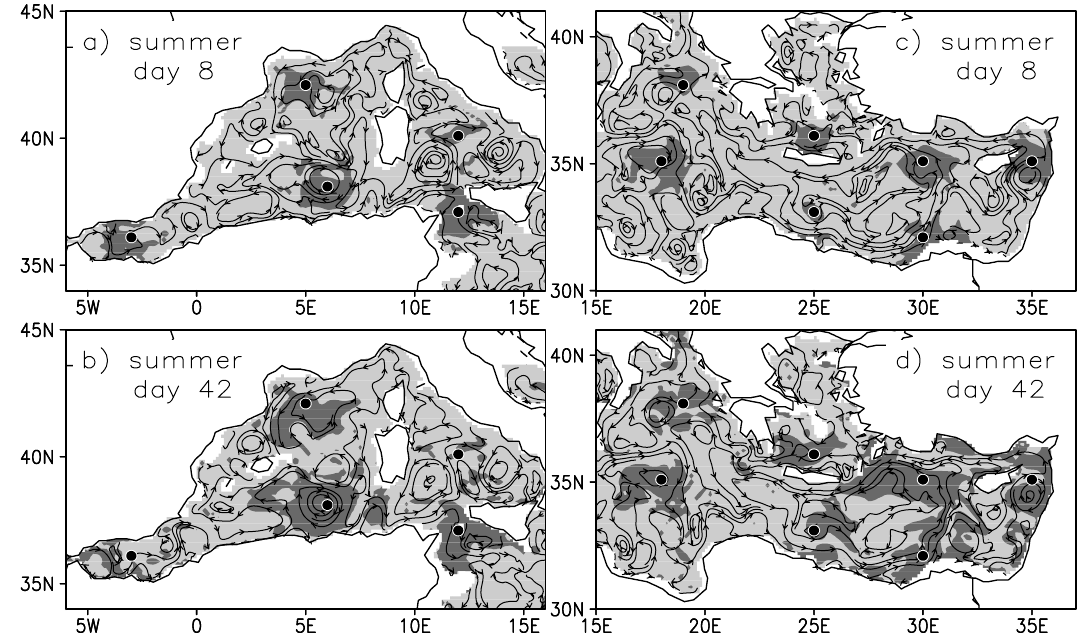
Fig. 11. Maps of data impact and basin circulation (streamlines) in the summer experiment at 50m depth: western basin, day 8 (a) and day 42 (b) ; eastern basin, day 8 (c) and day 42 (d) . The circulation shown is the average during the days 1–8 and 35–42, respectively. Dark grey indicates impact greater than 0.3. Black dots indicate the data positions.